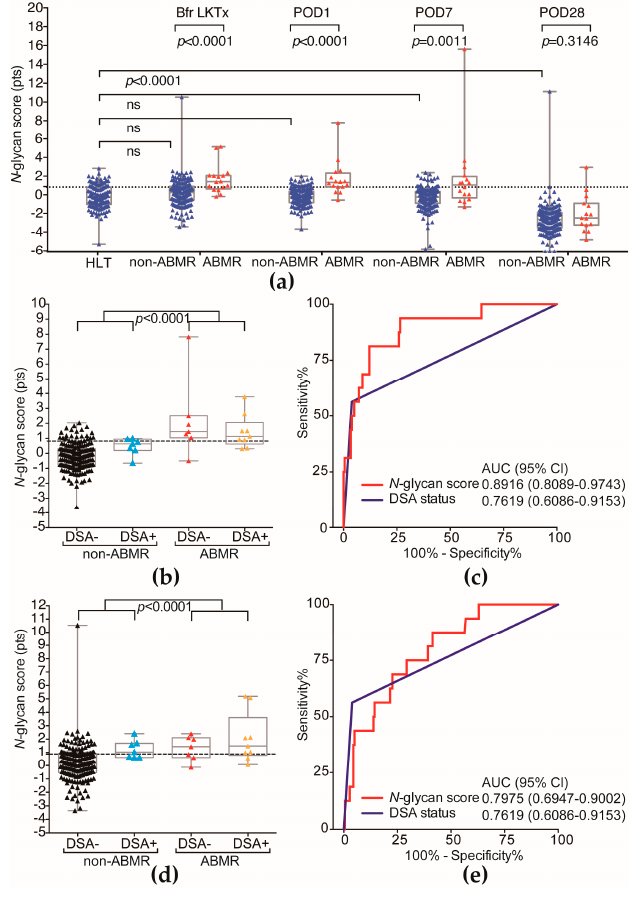
Figure 4. Prediction of ABMR by N -glycan score or preformed DSA. ( a ) Longitudinal follow-up of the N -glycan scores in the recipients who developed ABMR and those who did not. The N -glycan score of HLT was not significantly different from Bfr LKTx, postoperative day 1 (POD1) and POD7; ( b ) The N -glycan scores at POD1 in the recipients who developed ABMR and those who did not; ( c ) Receiver operating characteristic (ROC) curve analysis of N -glycan score at POD1 and preformed DSA status for detection of ABMR; ( d ) The level of the N -glycan score before LKTx (Bfr LKTx) in the recipients who developed ABMR and those who did not; ( e ) ROC curve analysis of the N -glycan score at Bfr LKTx and preformed DSA status for detection of ABMR. Table 4. Predictive value of N -glycan score at the cutoff point.